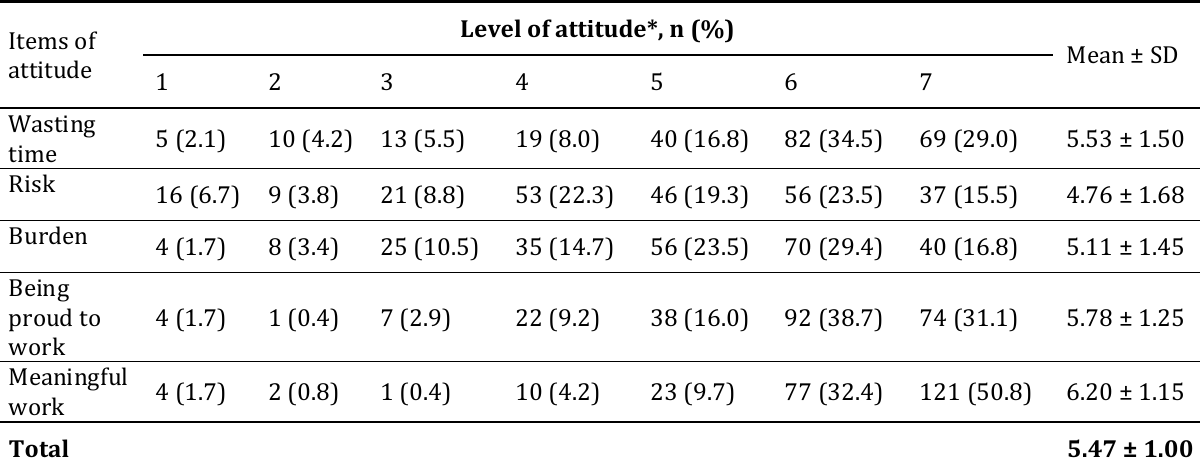
Table 4: Pharmacists’ attitudes on AMR management